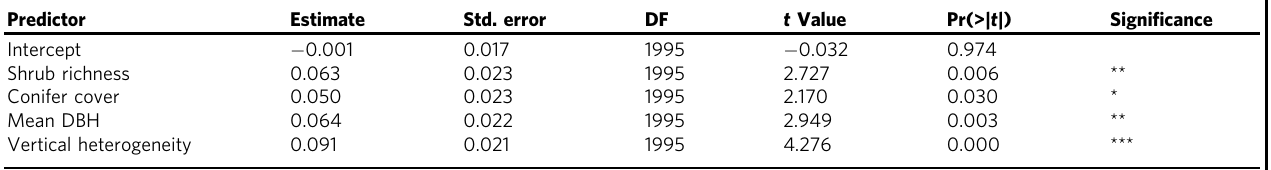
Table 1 Estimated net effects of forest attributes on ecosystem services